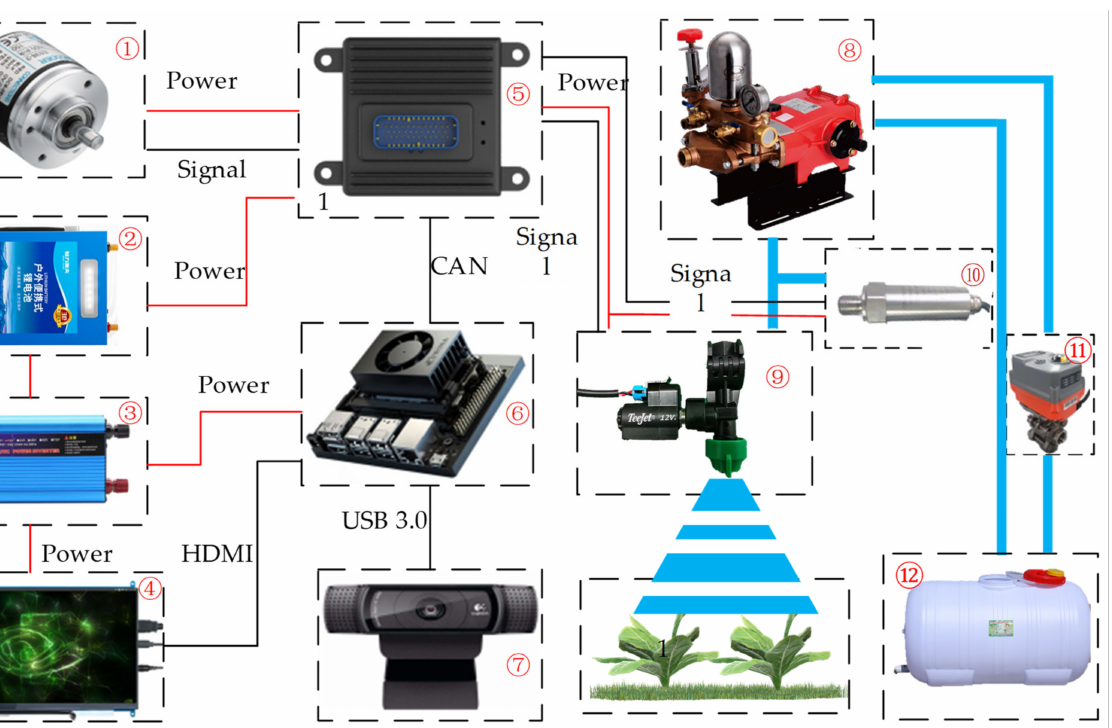
Figure 6. Diagram of the integrated target-oriented spray